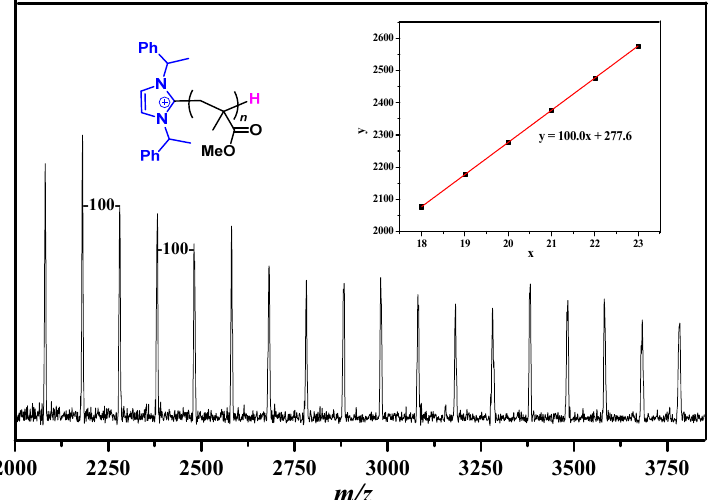
Figure 2. MALDI-TOF MS analysis for PMMA oligomers produced by Al(BHT) 2 Me/ (Ph)Et NHC in toluene at RT. Inset: a plot of m / z values (y) vs. the number of MMA repeat units (x).